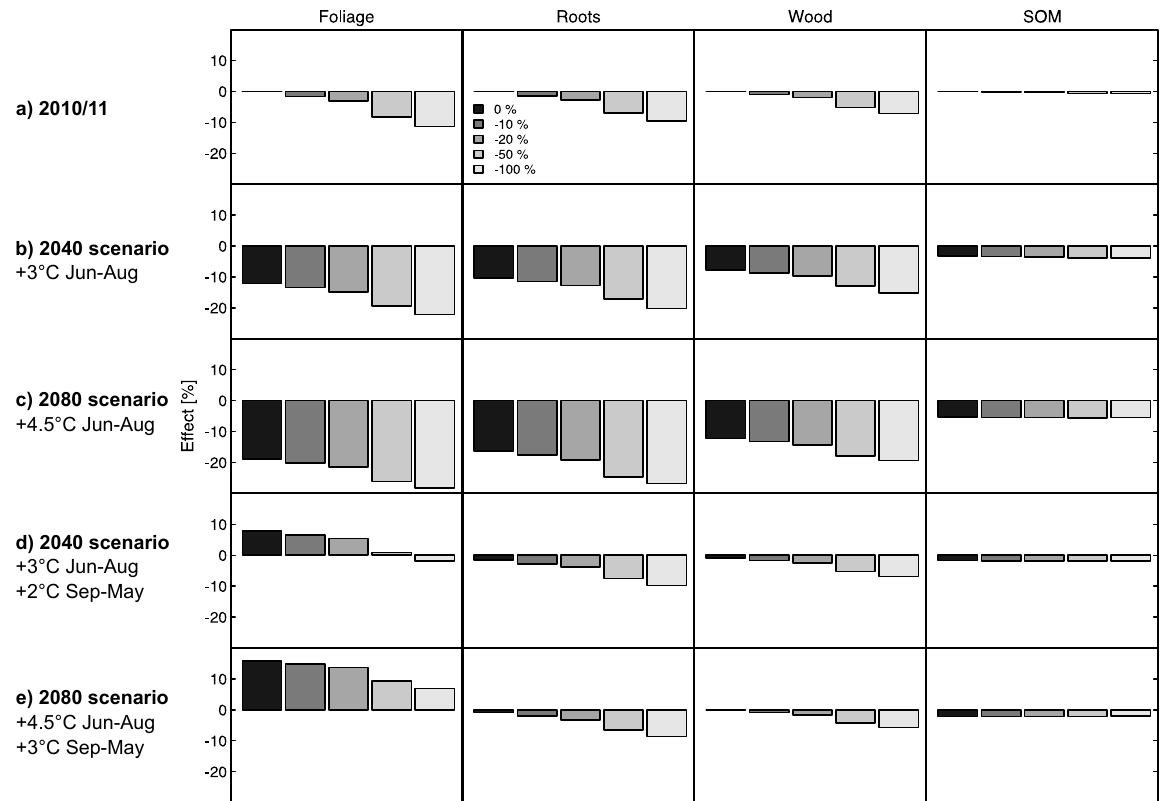
Figure 6. Effects of reduced precipitation and increased temperatures on simulated biomass and soil organic matter (SOM). percent mean annual changes of the 10yr model runs relative to the 2010/11 control conditions (0% rain reduction) are given. Precipitation from June to August was decreased by 0, 10, 20, 50 and 100% (10 and 20% reductions are in accordance with the climate scenarios for 2040 and 2080). 2010/11 temperature (a) , only summer temperature increased (b) and (c) , all-seasons temperature increased (d) and (e) . Note that CO 2 concentrations were 390ppm for all